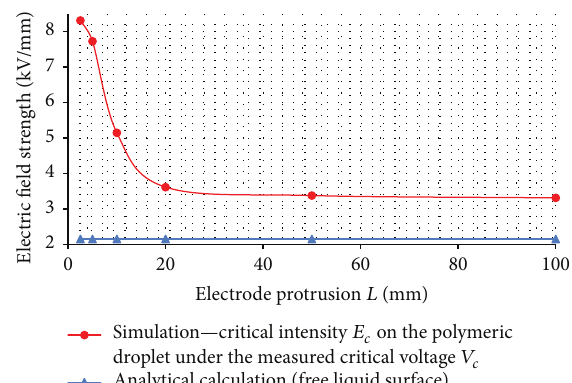
Figure 8: Dependence of the potential difference with respect to the rod electrode protrusion. Experimental results are compared with the theoretical prediction.